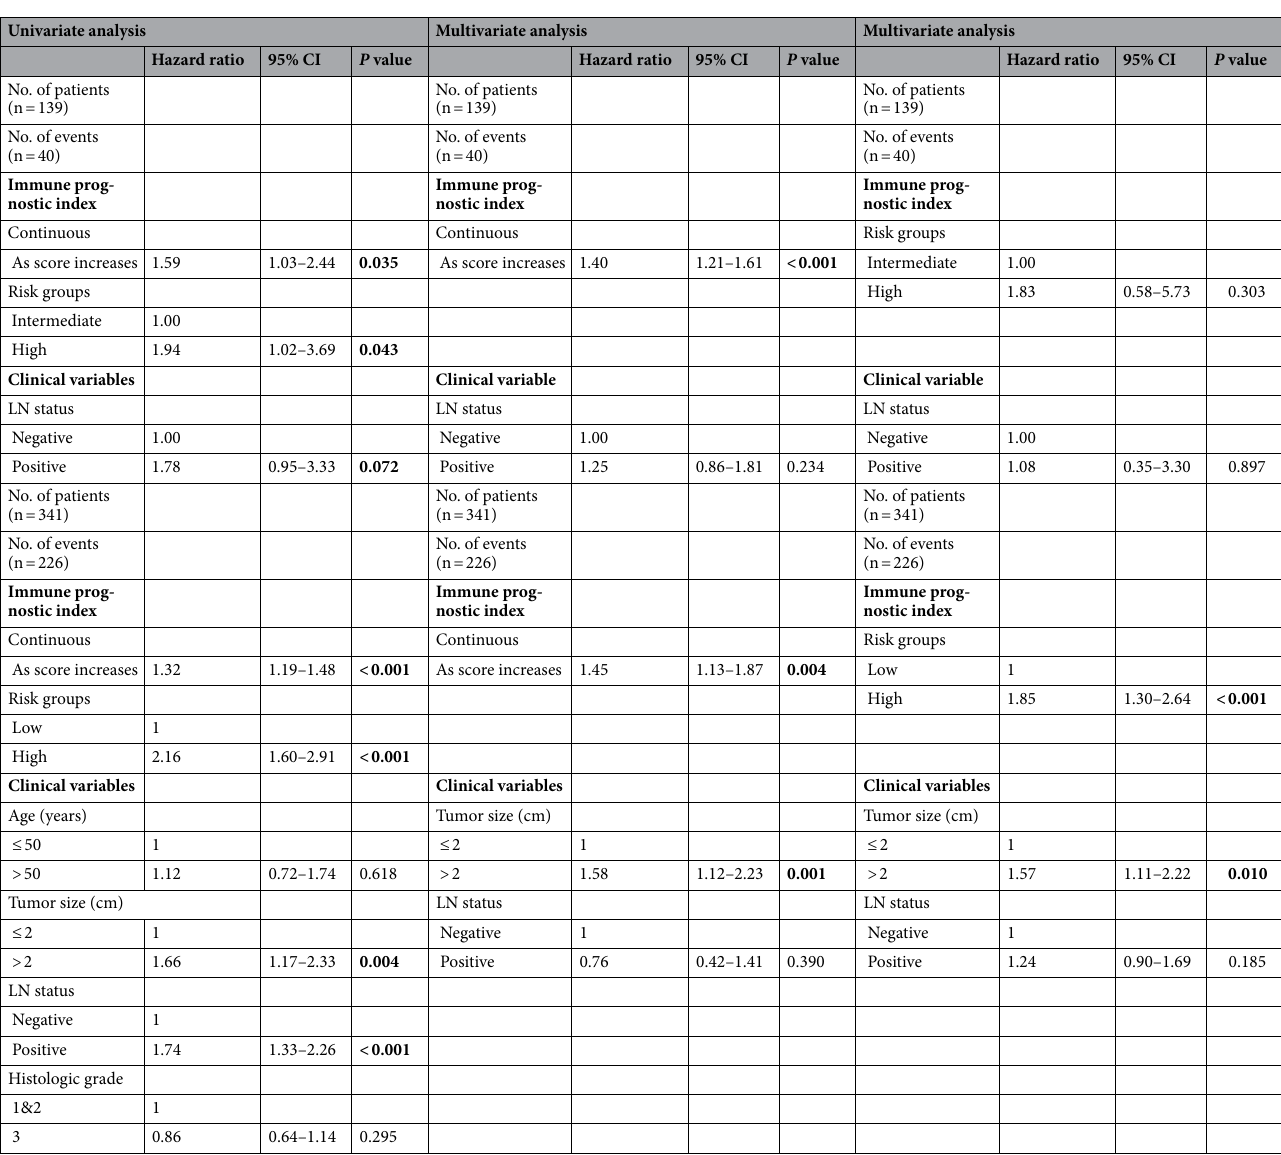
Table 4. Univariate and multivariate analyses of the immune prognostic index and clinicopathological variables in the validation datasets (GSE17705 and METABRIC). CI, confidence interval; GEO,